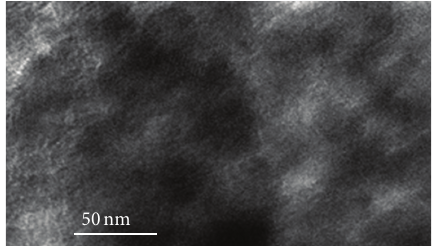
Figure 5: TEM image of Ce-RGO-TiO 2 .